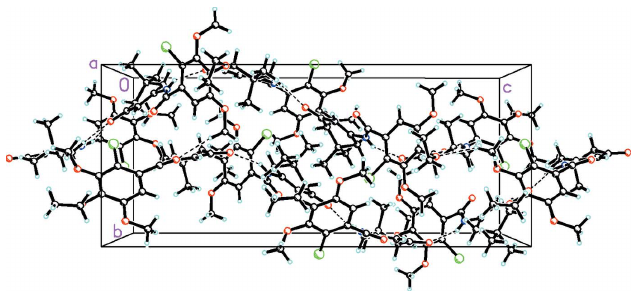
Figure 5 Packing diagram for 3b viewed along the a axis showing the molecules linked by both C—H (cid:3)(cid:3)(cid:3) O and C—H (cid:3)(cid:3)(cid:3) Cl interactions as well as N— H (cid:3)(cid:3)(cid:3) O hydrogen bonds (all shown by dashed bonds) into chains propagating in the [001]